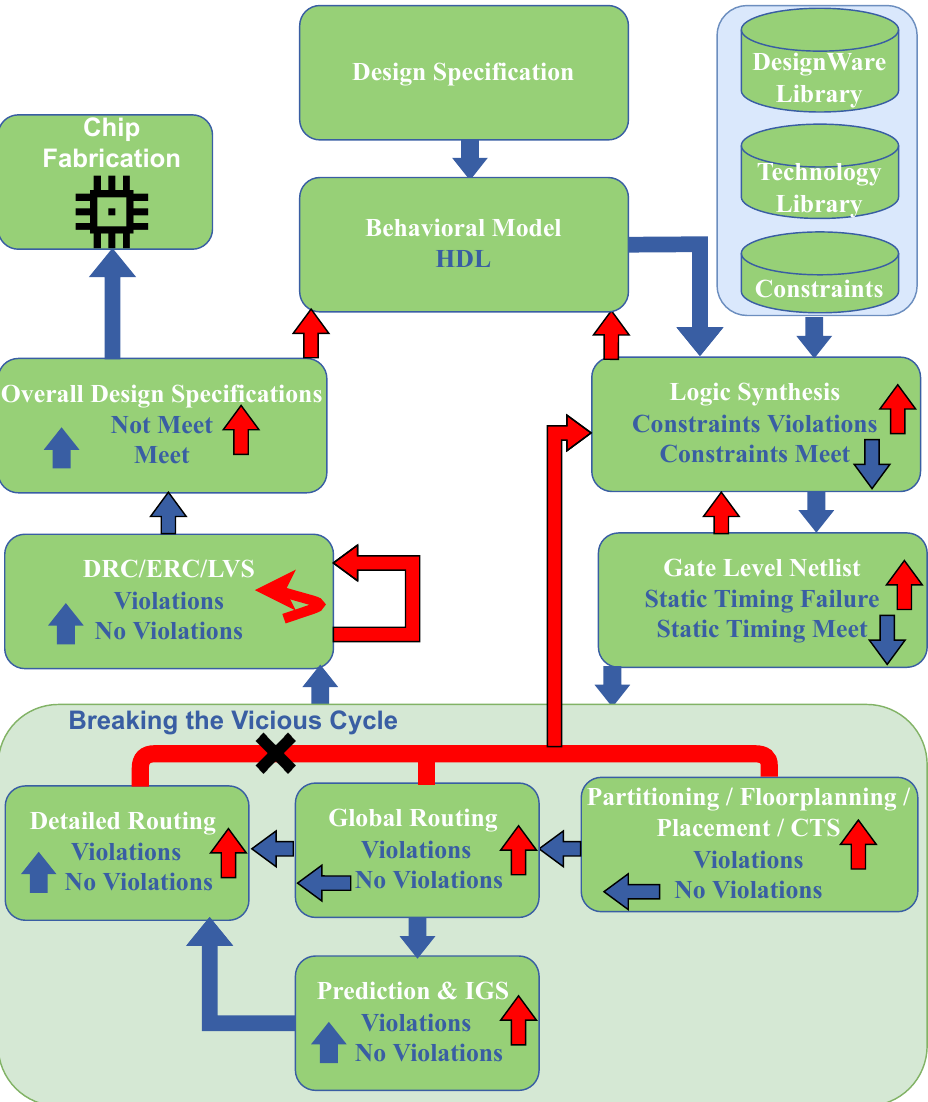
Figure 2. The proposed ML-based prediction and IGS methodology integrated with the existing EDA synthesis flow breaks the most expensive vicious cycle path from detailed routing to the behavioral